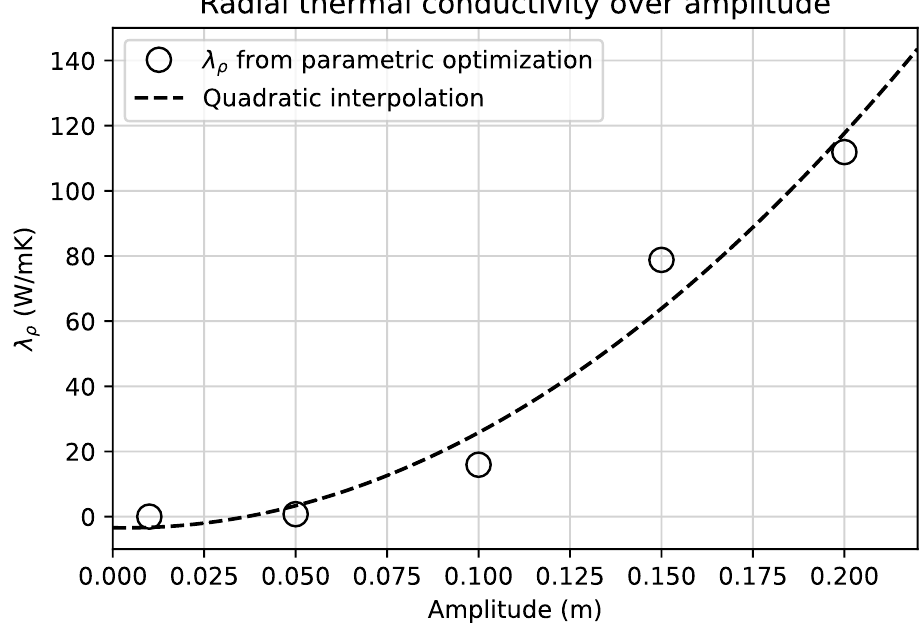
Figure 6. Resulting λ ρ from the optimization over the amplitude A . Shown also is a quatratic trend line.